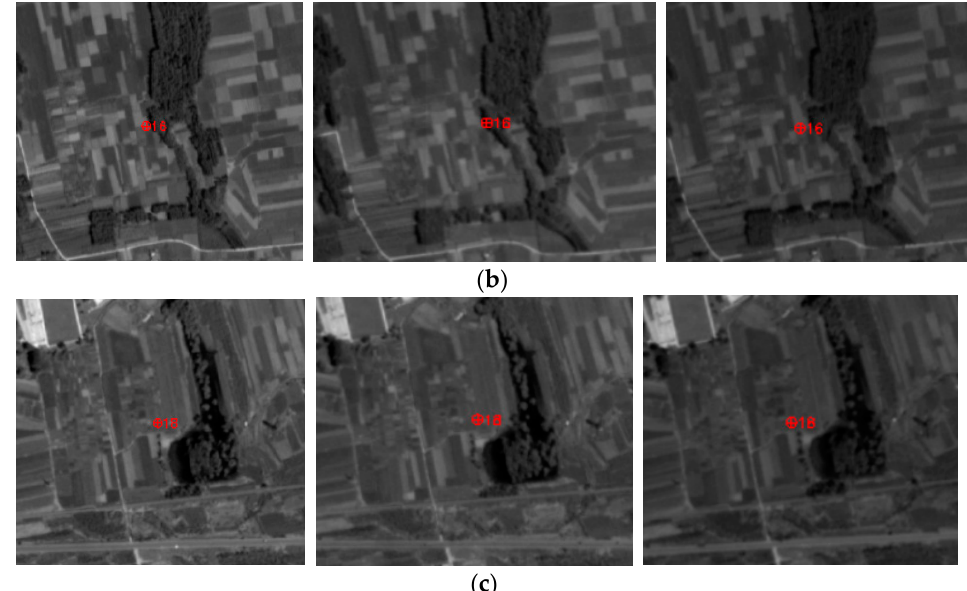
Figure 7. ZY3-02 stereo images and laser ranging data at the Taihang research area before combined adjustment. ( a ) Planar view of the LA (Laser Altimeter) data overlaid on the stereo images, ( b ) and ( c ) are detailed views for LAPs 16 and 18 overlaid on the stereo images, where the left image shows the nadir-view (NAD), the center one shows BWD and the right shows the FWD image.